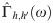
Expansion of effective interactions into contributions from hidden paths.A. Graphical representation of Eq (2). The linear response of the hidden network, Γ^h,h′(ω), has been expanded as a series (corresponding to the grey hidden nodes and links between them), such that each term in the overall series can be interpreted as a contribution from a path through which the pre-synaptic neuron r′ is able to send a signal to post-synaptic neuron r via 1, 2, etc. hidden neurons. This expression holds for any pair of neurons in the recorded subset. B. Quantitative expressions for each diagram in the series can be read off by assigning the shown factors for each hidden neuron node and each link between neurons, recorded or hidden, and multiplying them together. (No factor is assigned to the recorded neuron nodes). γh is the gain of neuron h and J^i,j(ω) is the true interaction from j to i in the frequency domain.